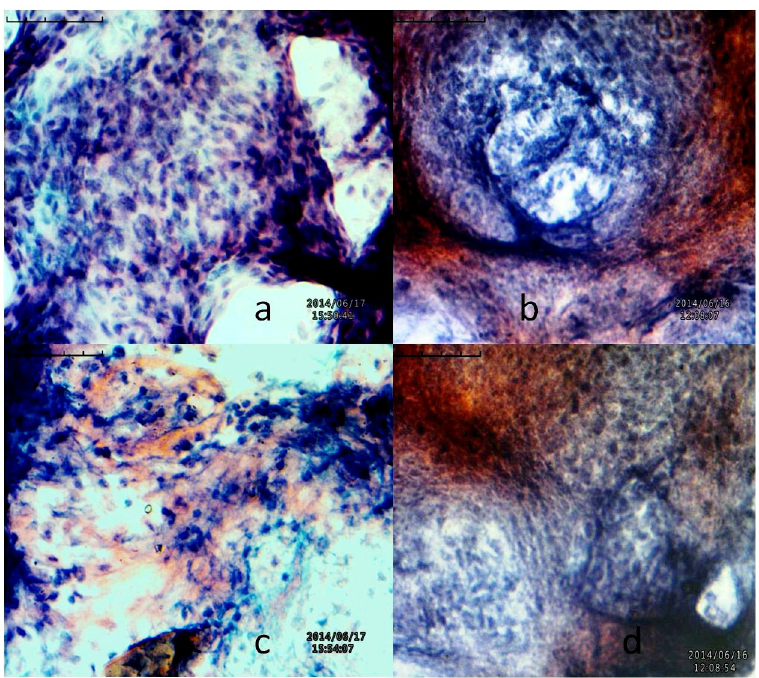
Fig 1. Histopathological examination of endo-ovarian tissue biopsy. a) polymorphonuclear cells were observed in endometrial tissue biopsies; b) Severe lesions with granulomatous filled with beaded and malignant lymphoid cells were observed in endo-ovarian tissue biopsies; c) appearance of spindle-cells with superficial strips of positive endometrial glands and stroma; d) lymphocytic infiltrations and initial stages of granulomatous were observed. Note : The microscopic studies were carried out with tissue biopsies and aspirated fluids containing tissue pieces. Thereafter, the slides were viewed under bright field (40X), Inverted microscope. The contrasts of the photographs are changed to improve the